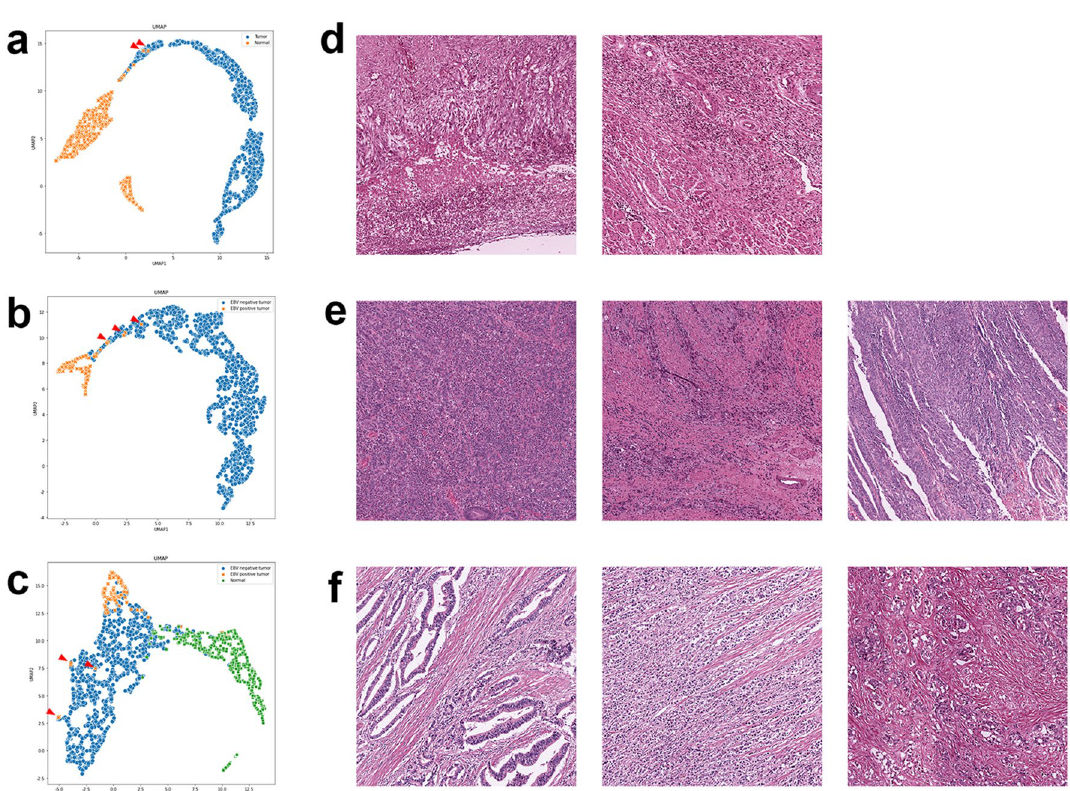
Figure 2. Uniform Manifold Approximation and Projection (UMAP) visualization of neural network latent space and examples of false results. All input patches were fed into classification models and the corresponding post-convolution dense vectors (1024-length) were generated. All the vectors were mapped into 2-dimensional space using UMAP. Each point corresponds to a patch in ( a ) the tumor classifier, ( b ) the EBV classifier, and ( c ) the 3-Class classifier, colored by tissue type (tumor vs. normal) and tumor type (EBV positive vs. EBV negative). Histology images (d–f) of false predictions (red triangles) of each classifier (a–c), which are located apart from their corresponding cluster on UMAP. These points were examined to investigate potential reasons for